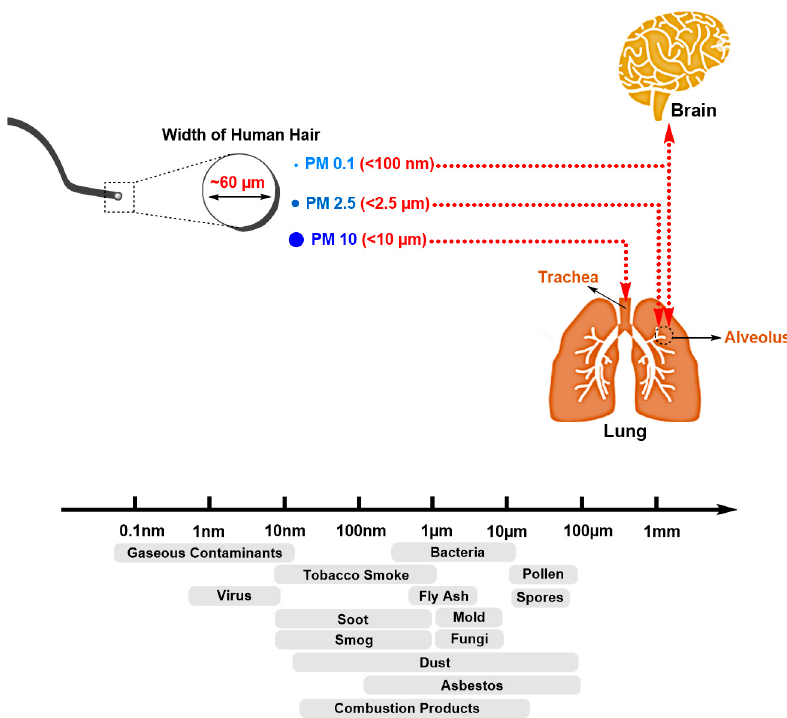
Figure 3. One can visualize how small the air particles are by comparing them to the human hair. The hair cross-section diameter being ~60 µm, about six PM10 particles and 24 PM2.5 particles could extend over the hairs cross-section perimeter. PM2.5 (or fine PM), tend to penetrate into the gas-exchange regions of the lung (alveolus).